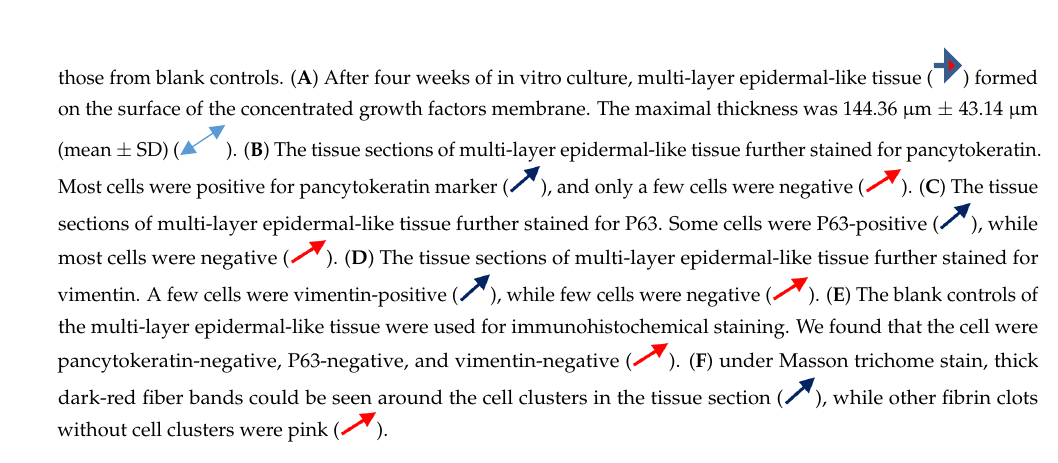
). Figure 2F: under Masson trichome stain, ). Figure 2C: The tissue sections of multi-layer epidermal-like tissue further stained for P63. Some cells were P63- ). Figure 2D: The tissue sections of multi-layer epidermal-like tissue further stained for vimentin. A few cells were vimentin-positive ( ), while few cells were negative ( ). Figure 2E: